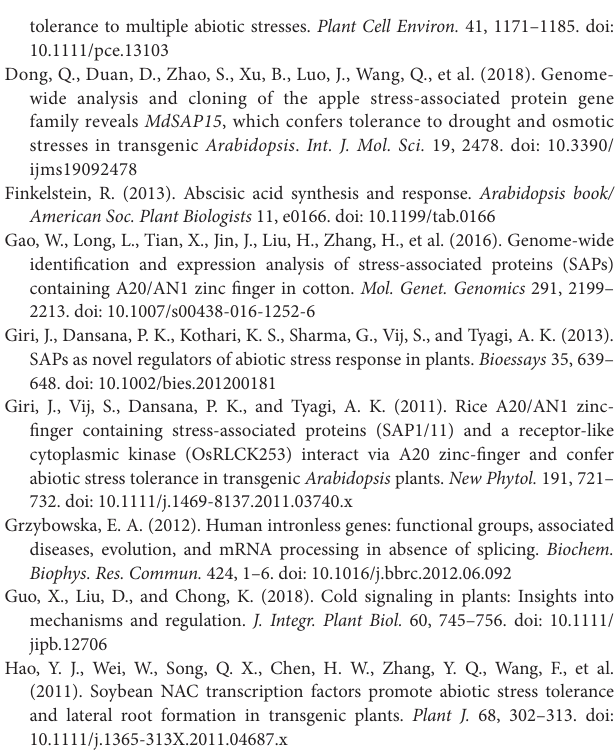
FiGURe S1 | Multiple alignments of soybean SAPs. DNAMAN 8.0 software was used for the alignments. A20, AN1 and C2H2 zinc finger domains are indicated in red, green, and blue boxes, respectively. Amino acids in different colors indicate sequence similarity. (Similarity: red = 100%; coral > 75%; pink > 50%). FiGURe S2 | Main cis -acting elements in the promoter regions of soybean SAP genes. ABRE: ABA-responsive element; ARE: anaerobic-responsive element; CGTCA: MeJA responsiveness; ERE: ethylene-responsive element; GARE-motif: gibberellin-responsive element; LTR: low-temperature responsive element; MBS: MYB-binding site involved in drought response; MYB: response to drought and ABA signals; MYC: response to drought, ABA and cold signals; STRE: stress-response element; TC-rich repeat: defense and stress responsiveness; TCA: salicylic acid-responsive element; TGA element: auxin-responsive element; W-box: elicitation, wounding, and pathogen responsiveness/binding site of WRKY-type transcription factors; WUN-motif: wooden response. FiGURe S3 | Chromosomal locations of the soybean SAP genes. The chromosomal locations of the soybean SAP genes refer to the genomic information provided on Phytozome v10.3. The scale bar represents megabases (Mb). Abbreviation: Chr, chromosome. FiGURe S4 | Detection of GmSAP16 in WT and transgenic Arabidopsis lines. (A) Relative transcript level of GmSAP16 in WT and transgenic Arabidopsis lines determined by RT-qPCR. Error bars indicate the SD of three biological replicates. (B) The transcript level of GmSAP16 was detected in WT and transgenic plants by semi-quantitative PCR. FiGURe S5 | Relative transcript level of GmSAP16 in CK and transgenic soybean hairy roots determined by RT-qPCR. The data were normalized to the soybean internal control (GmCYP2) . Error bars indicate the SD of three biological replicates. TABle S1 | The primers and sequences used for the